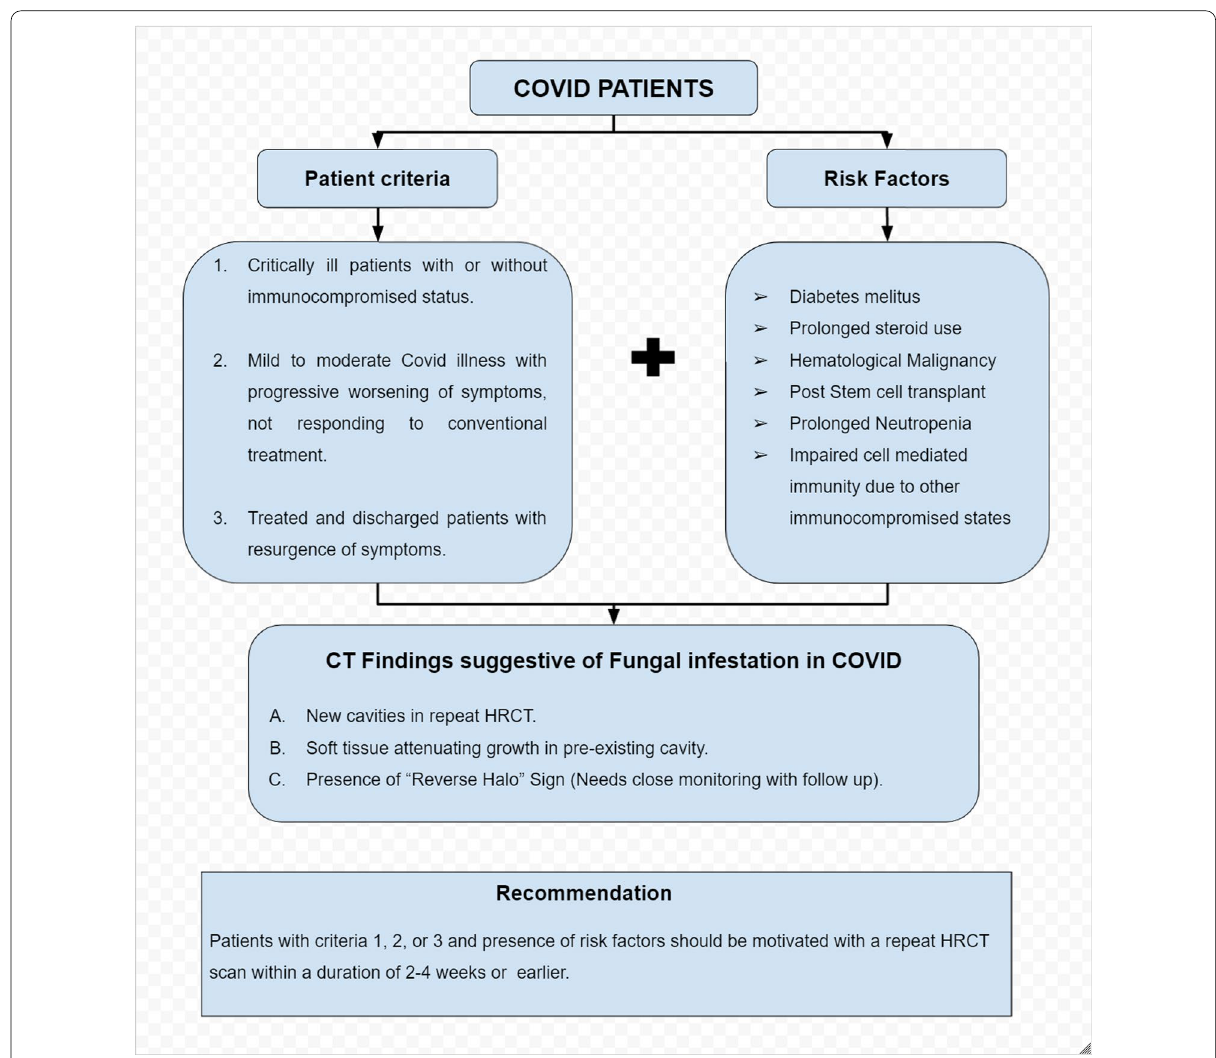
Fig. 7 Recommended protocol for triaging the COVID patients with suspicious pulmonary fungal